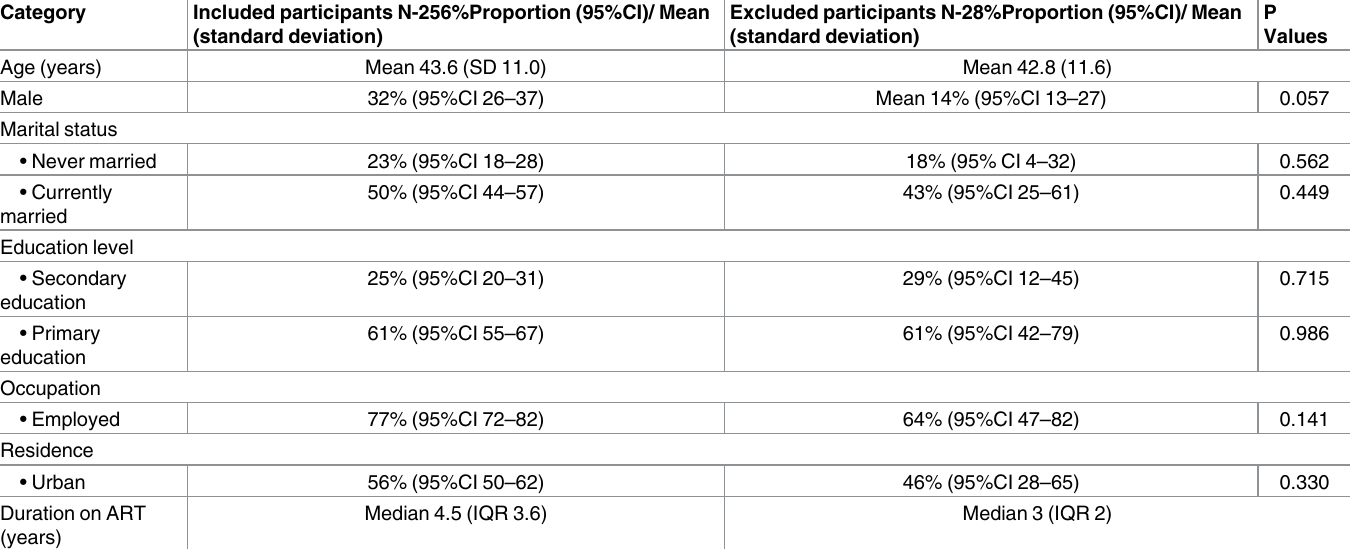
Table 1. Demographic characteristics of the recruited and excluded patients.